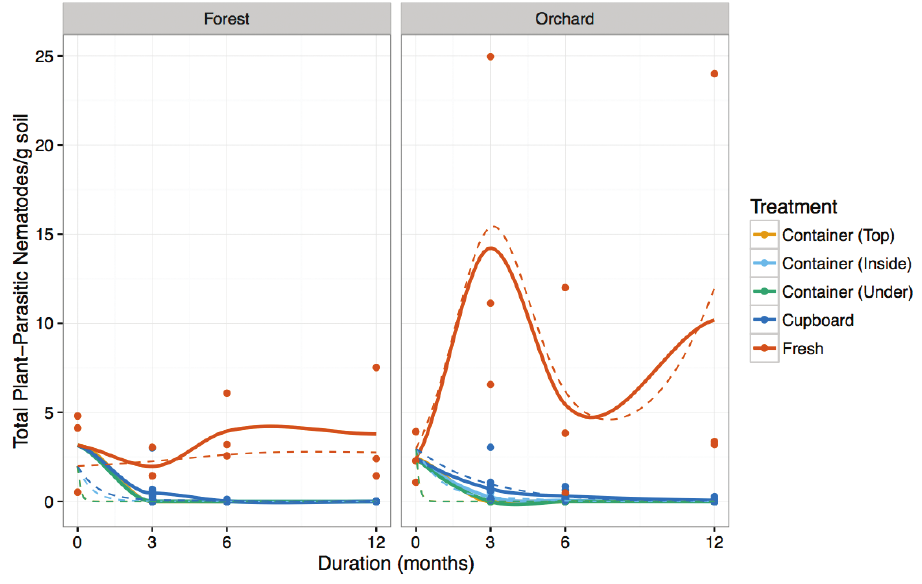
Figure 5. Scatterplot showing changes in mean plant-parasitic nematodes/ g soil at 0, 3, 6 and 12 months measured in soil recovered from on, in and under four sea containers and inside four cupboards. Solid lines show the smoothed means and dashed lines predictions from the preferred